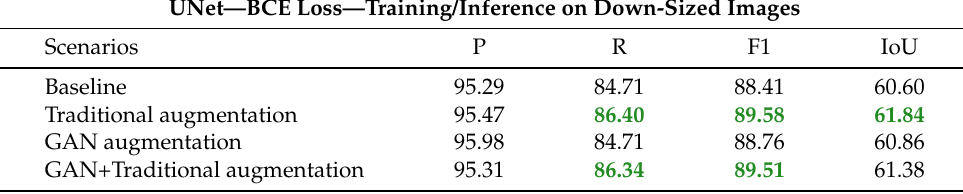
Table 8. UNet performance, Experiment